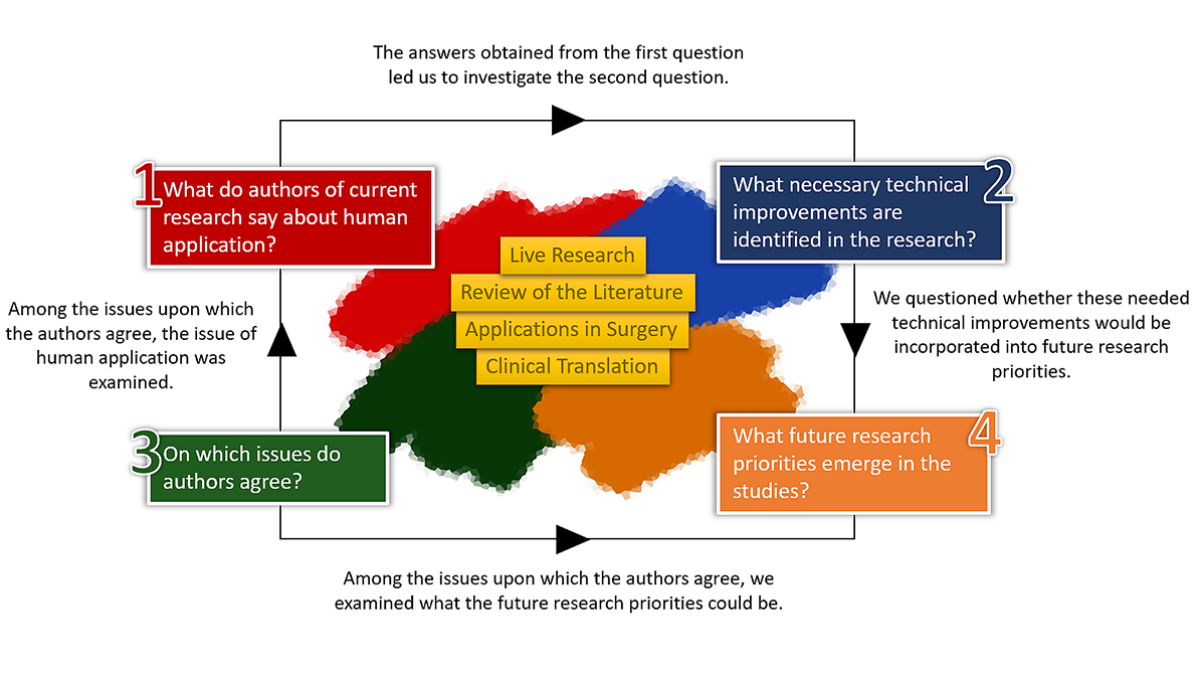
Figure 1. Conceptual framework of the scoping